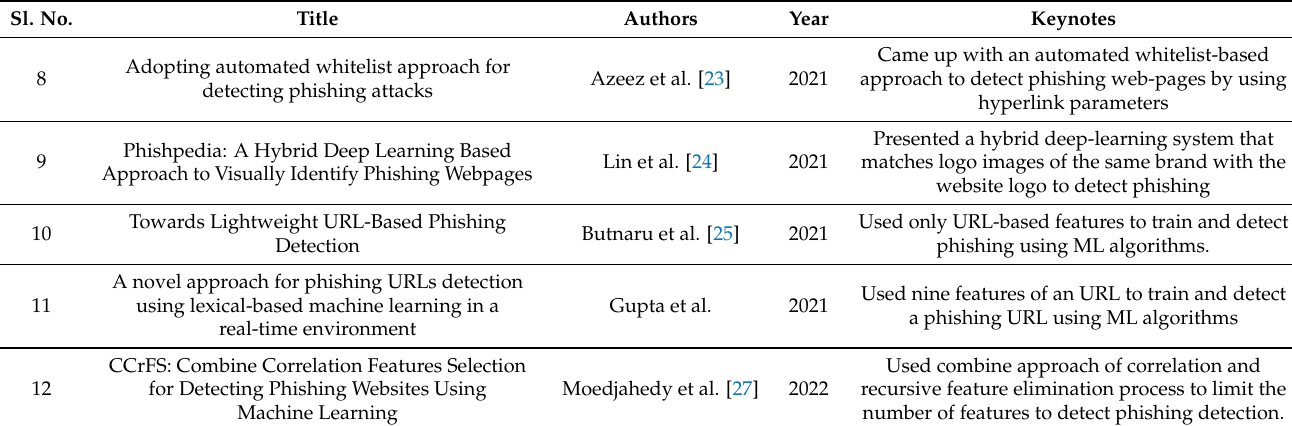
Table 2. Summary of survey works on phishing detection.